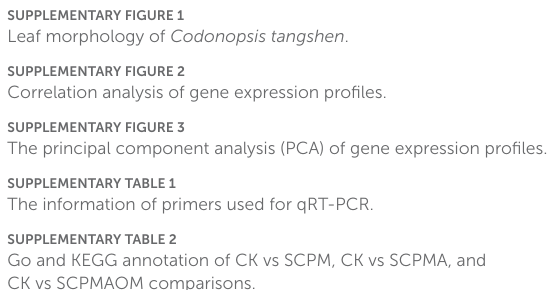
SUPPLEMENTARYFIGURE2 Correlation analysis of gene expression profiles. SUPPLEMENTARYFIGURE3 The principal component analysis (PCA) of gene expression profiles. SUPPLEMENTARYTABLE1 The information of primers used for